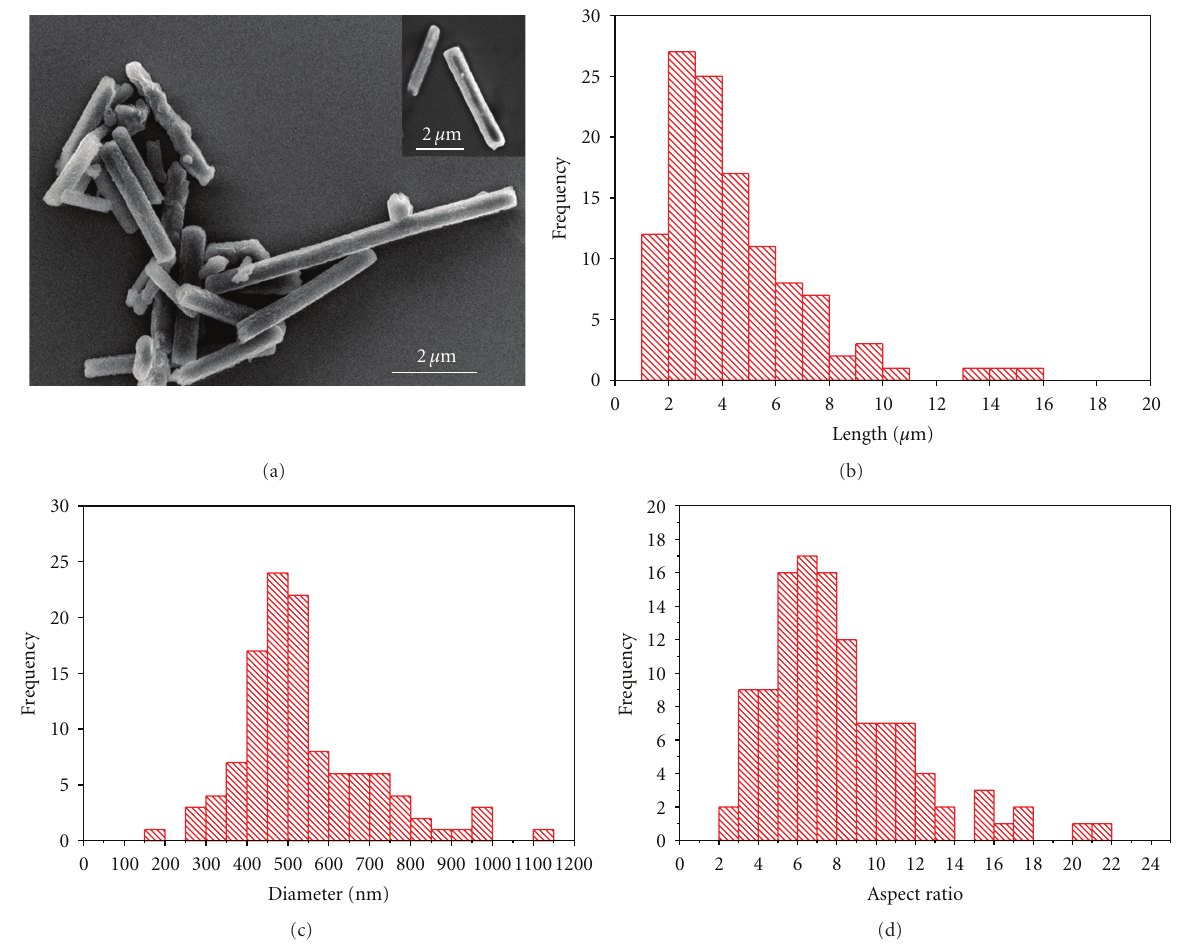
Figure 1: (a) SEM images, (b) length, (c) diameter, and (d) aspect ratio (length/diameter) distributions of the synthesized C 60 NWs.